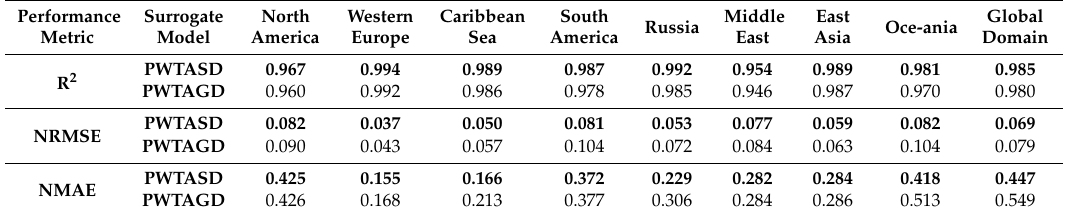
Table 5. Comparisons of R 2 , NRMSE, and NMAE for PWTASD and